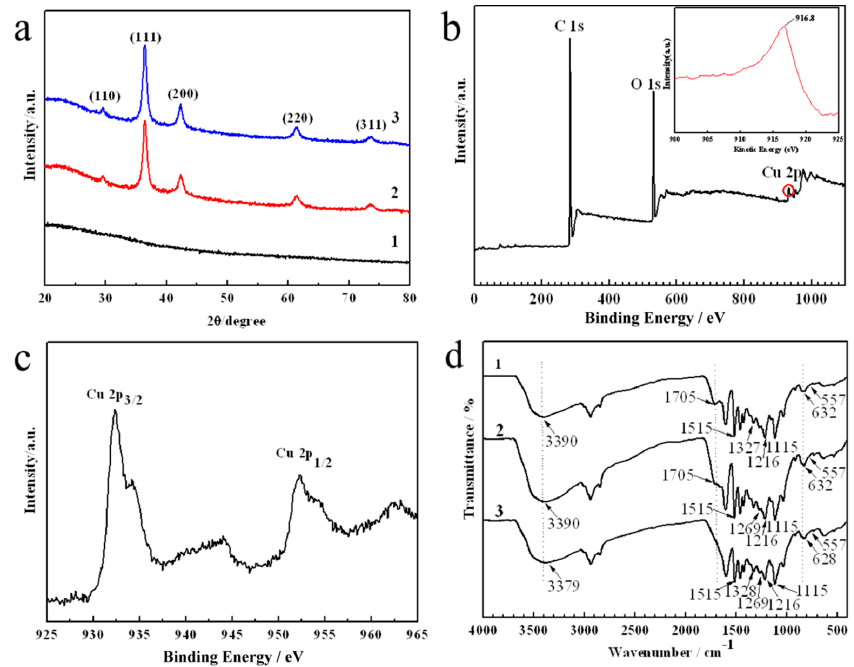
Figure 4. The XRD, XPS, Cu L3VV signal, and FTIR spectra of the samples: ( a ) the XRD of lignin nanospheres and Cu 2 O@L: (a-1) XRD of lignin nanospheres, (a-2) Cu 2 O@L, and (a-3) fourth-time-reused Cu 2 O@L; ( b ) the XPS and Cu L3VV signal of Cu 2 O@L; ( c ) Cu 2p XPS spectrum peaks of Cu 2 O@L; ( d ) the FTIR spectra of lignin and lignin nanosphere-based catalyst: (d-1) raw lignin, (d-2) lignin nanospheres, and (d-3) Cu 2